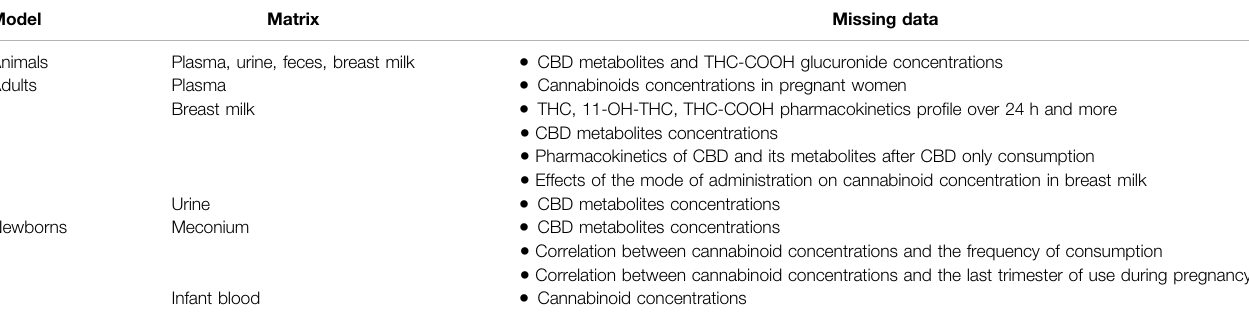
TABLE 4 | Missing data on the pharmacokinetics of cannabinoids in animals, adults and newborns. Model Matrix Missing data